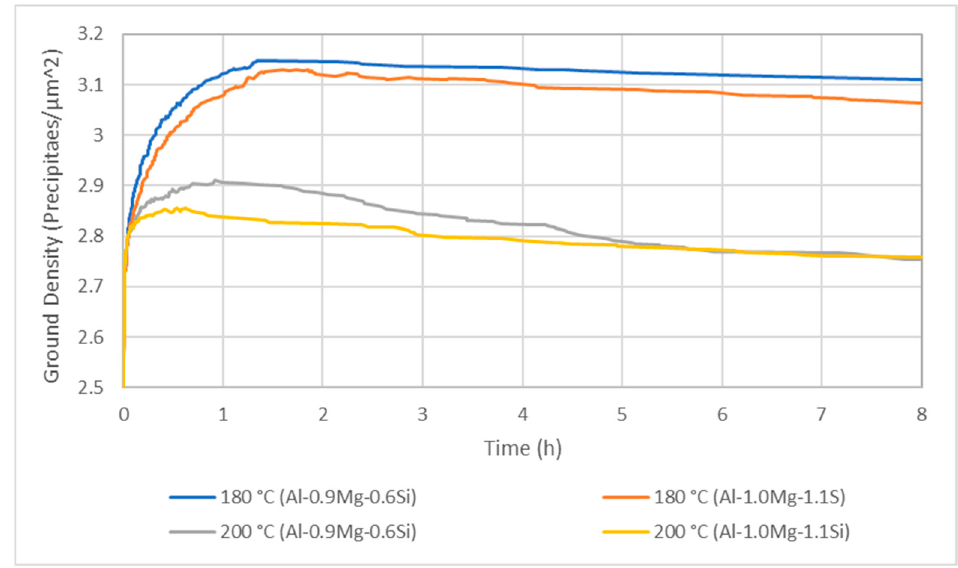
Figure 10. Temporal evolution of the precipitate’s density.